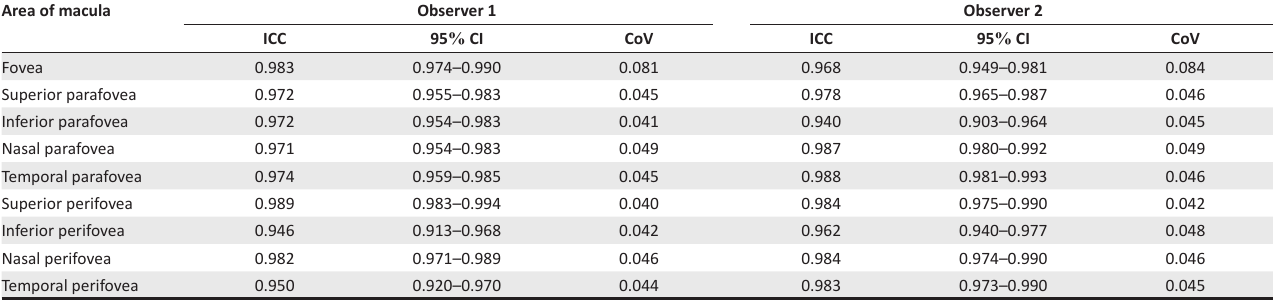
FIGURE 1: Early Treatment Diabetic Retinopathy Study retinal thickness map from the iVue-100 optical coherence tomographer. TABLE 1: Intra-class correlation coefficient with 95 % confidence intervals and coefficient of variation for each observer for macular thickness measured at the different areas of the right eyes of 50 participants (the majority being Indian or African) aged 18–51 years. Area of